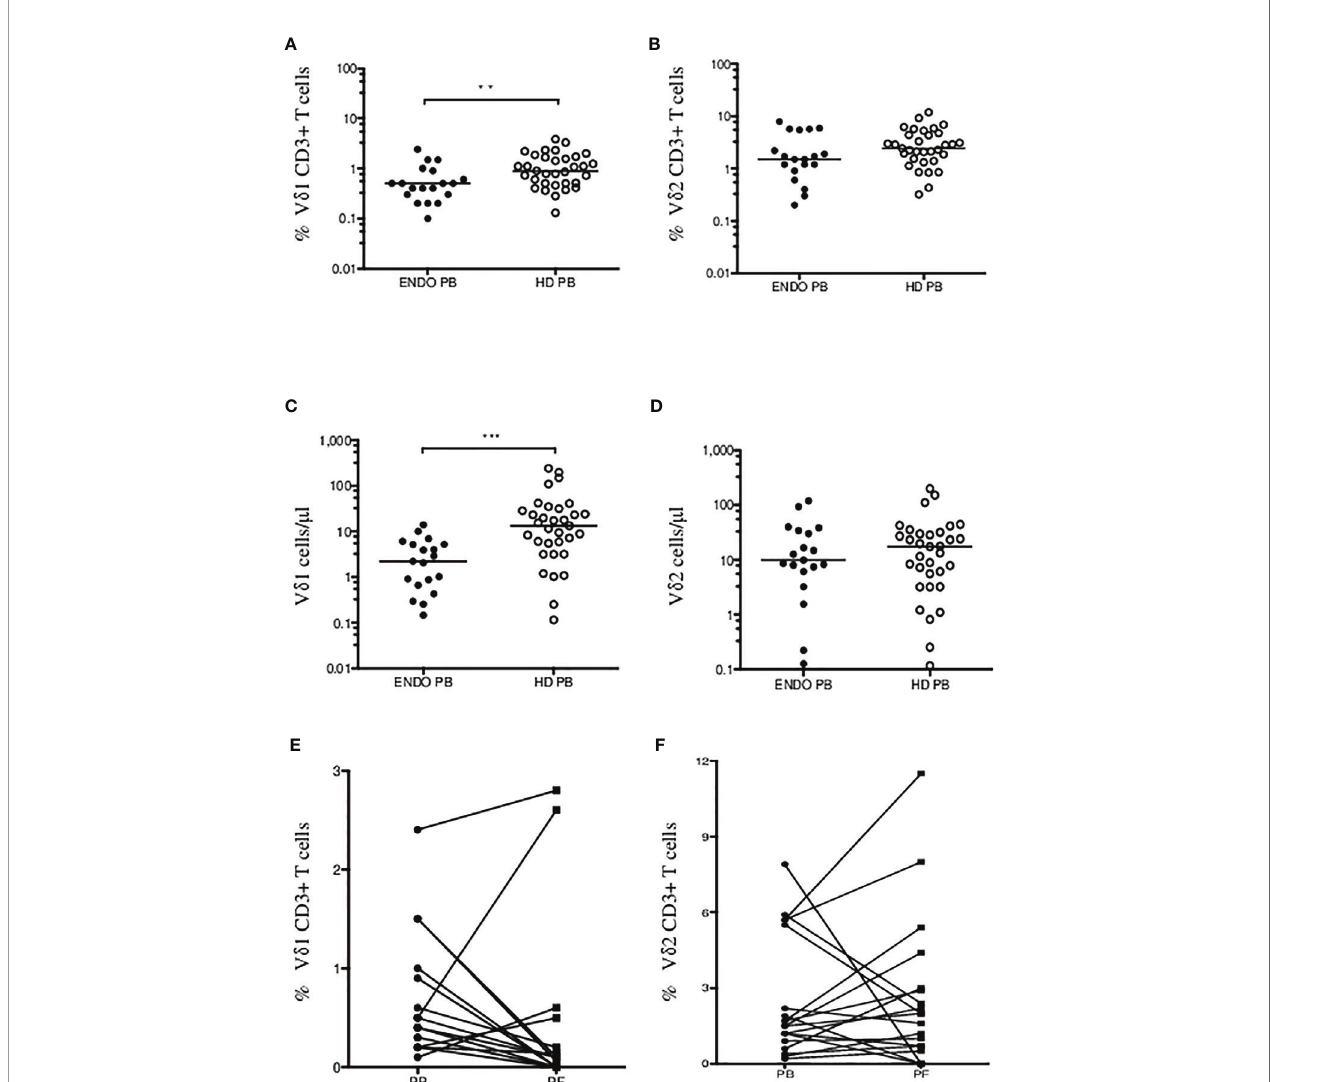
FIGURE 2 | Summary of V d 1 and V d 2 gd T cells in endometriosis patients. Percentage of CD3+ V d 1 (A) and V d 2 (B) gd T cells in endometriosis patients (ENDO, fi lled circles) and age- and sex-matched healthy donors (HD, empty circles) are shown. Absolute counts of V d 1 (C) and V d 2 (D) gd T cells in PB in patients compared with HD were determined. Analysis of V d 1 (E) and V d 2 T cells (F) in patient ’ s peripheral blood (PB) and paired peritoneal fl uid (PF) samples. The median values are shown. Statistically signi fi cant differences are presented as ** p = 0.008; *** p =